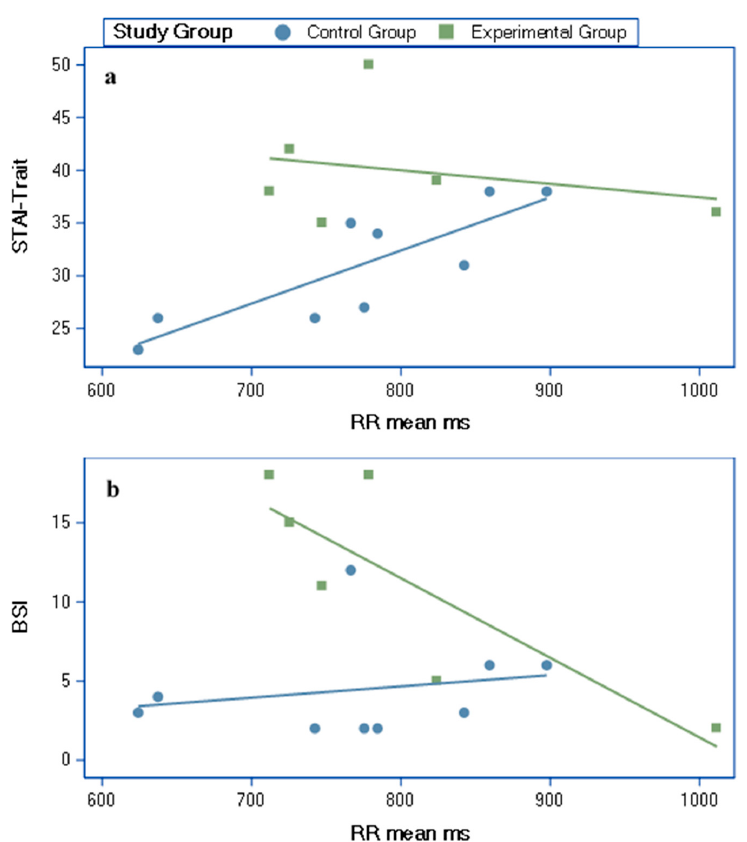
Figure 3. Partial correlations (age adjusted) between RR mean ms and ( a ) the STAI-Trait and ( b ) the short version of the BSI self-report scores. RR Mean ms: R-R interval mean in milliseconds; STAI-Trait: Trait sub-scale of the Spielberger state-trait anxiety inventory questionnaire; BSI: Brief Symptom Inventory.